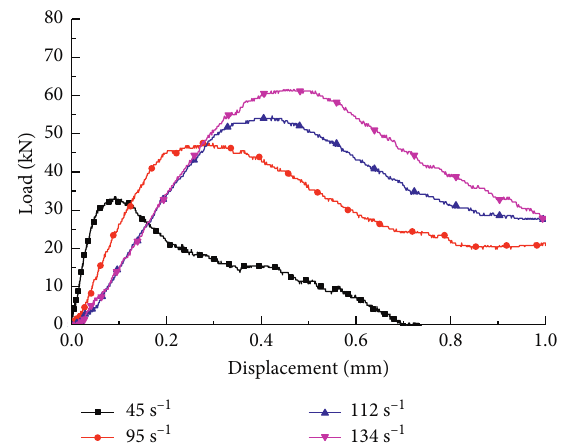
Figure 5: Dynamic splitting tensile load-displacement curves of the limestone disk specimen ( P s � 2MPa).